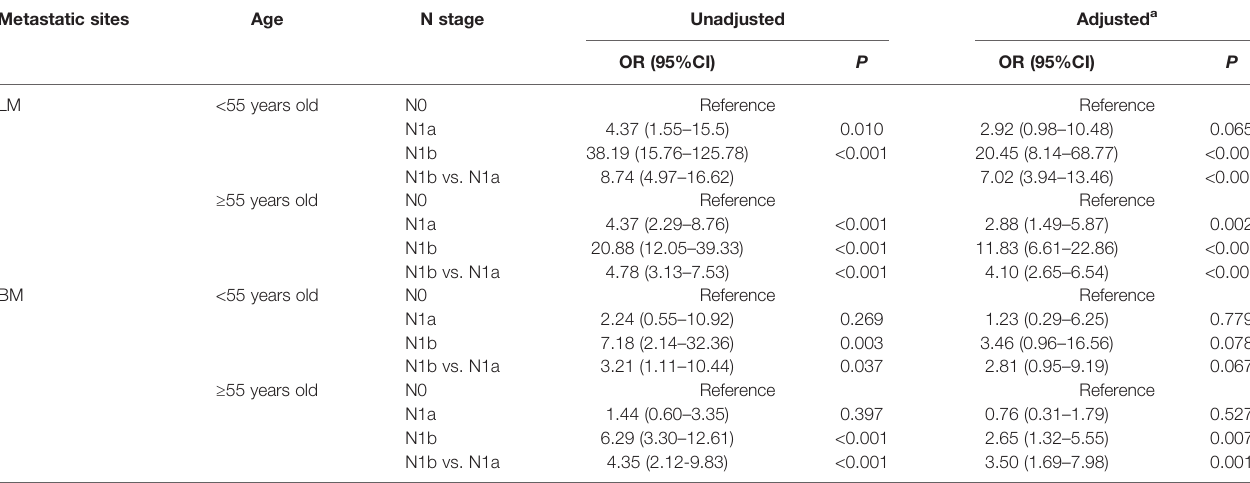
TABLE 3 | The impact of N classi fi cation on lung and bone metastasis based on age strati fi